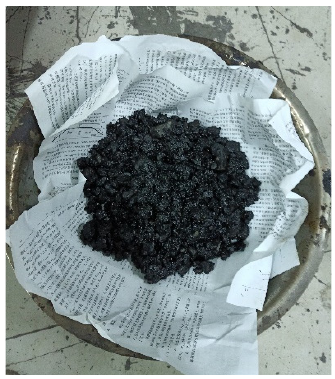
Figure 7. Reclaimed asphalt mixture.